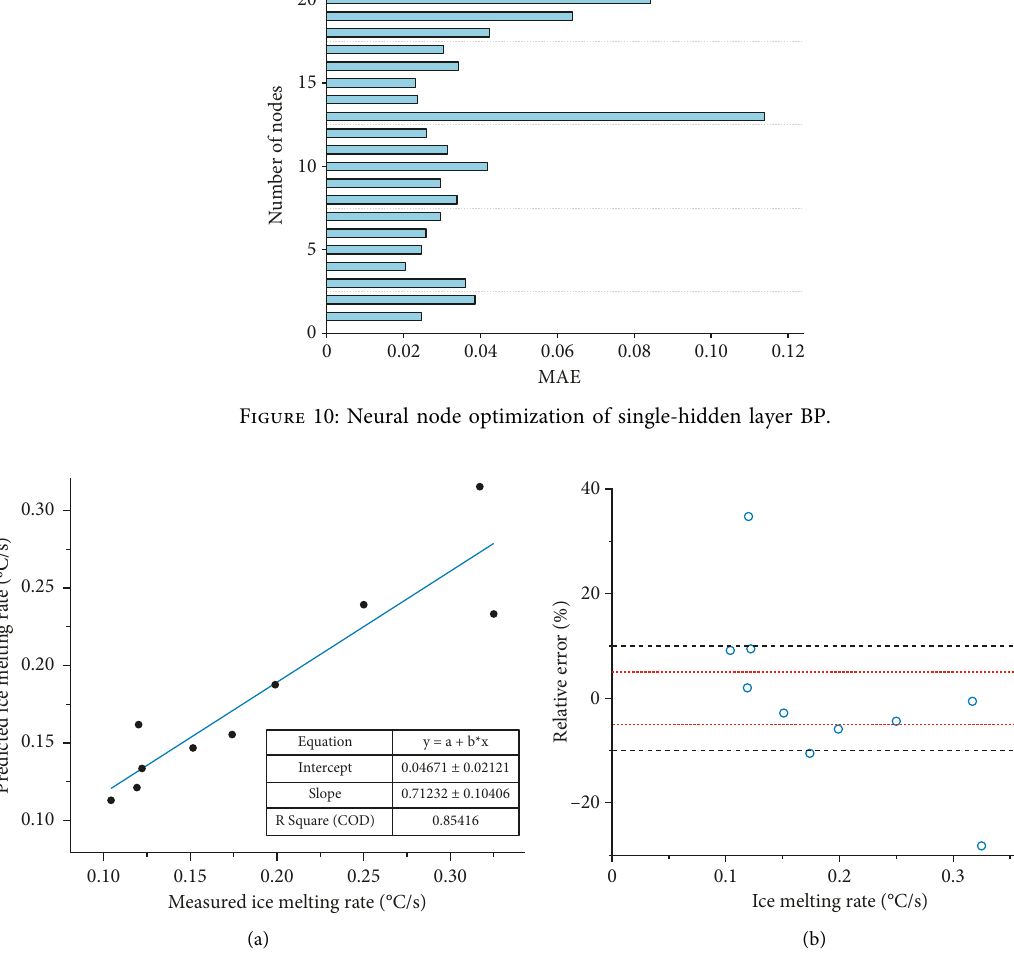
Figure 11: Fitting effects of single-hidden layer BP model. (a) Fitting curve. (b) Fitting error.